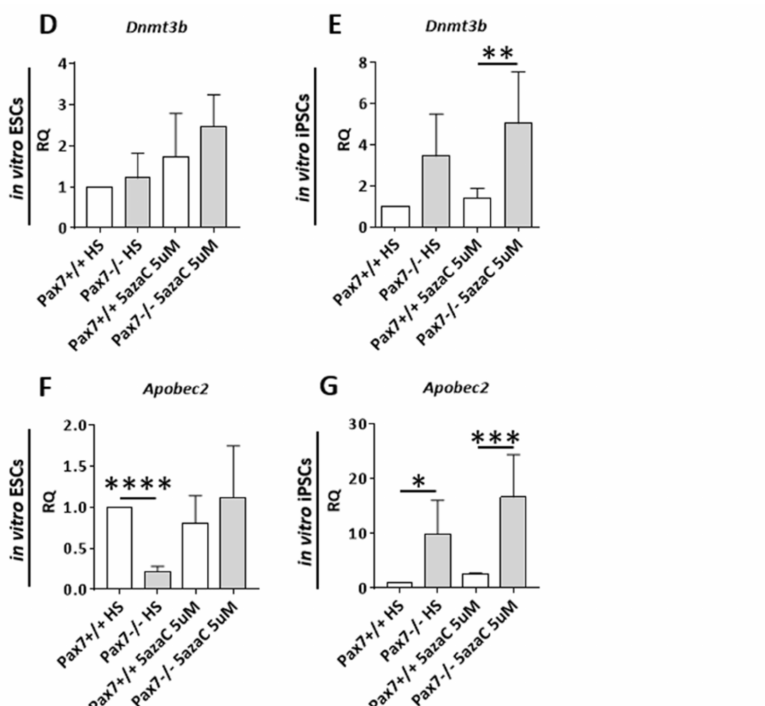
Figure 3. Analysis of factors regulating pluripotency and DNA methylation in Pax7 +/+ and Pax7 − / − ESC and iPSCs—undifferentiated and differentiating in vitro treated with HS and 5-azacytidine and in vivo in teratomas. ( A ) Expression of mRNAs Dnmt3b and Apobec2 in the teratomas generated from Pax7 +/+ and Pax7 − / − ESCs. Global DNA methylation (5-mC, proportion of methylated cytosines relative to the cytosine genomic content). ( B ) Expression of mRNAs encoding OCT3/4 ( Pou5f1 ) and NANOG ( Nanog ) in undifferentiated Pax7 +/+ and Pax7 − / − ESCs and iPSCs. ( C ) Expression of mRNAs encoding DNMT3b ( Dmt3b ) in undifferentiated Pax7 +/+ and Pax7 − / − ESCs and iP- SCs. ( D ) Expression of mRNA encoding Dnmt3b in differentiating Pax7 +/+ and Pax7 − / − ESCs treated with HS and 5azaC. ( E ) Expression of mRNAs encoding Dnmt3b in differentiating Pax7 +/+ and Pax7 − / − iPSCs treated with HS and 5azaC. ( F ) Expression of mRNAs encoding Apobec2 in differentiating Pax7 +/+ and Pax7 − / − ESCs treated with HS and 5azaC. ( G ) Expression of mRNAs encoding Apobec2 in differentiating Pax7 +/+ and Pax7 − / − iPSCs treated with HS and 5azaC. White bars—values for Pax7 +/+ teratomas; gray bars—values for Pax7 − / − teratomas. Expression was related to the levels observed in 13.5 d.p.c. mouse embryo (E13.5) and normalized to mRNA en- coding β -actin ( Actb ). Data are presented as mean ± SD. (A) Stars represent results of Student’s unpaired two-tailed t -test: ** p < 0.01, *** p < 0.001. (B- Klf4 ) Data characterized by non-normal distribution—stars symbolize results of Kruskal–Wallis and post-hoc Dunn’s multiple comparisons test. The level of significance was set at p < 0.05. (B- Pou5f1 , Nanog, Dnmt3b , D–G) Stars symbolize result of two-way ANOVA and post-hoc Sidak’s multiple comparisons test: * p < 0.05; ** p < 0.01, *** p < 0.001, **** p <